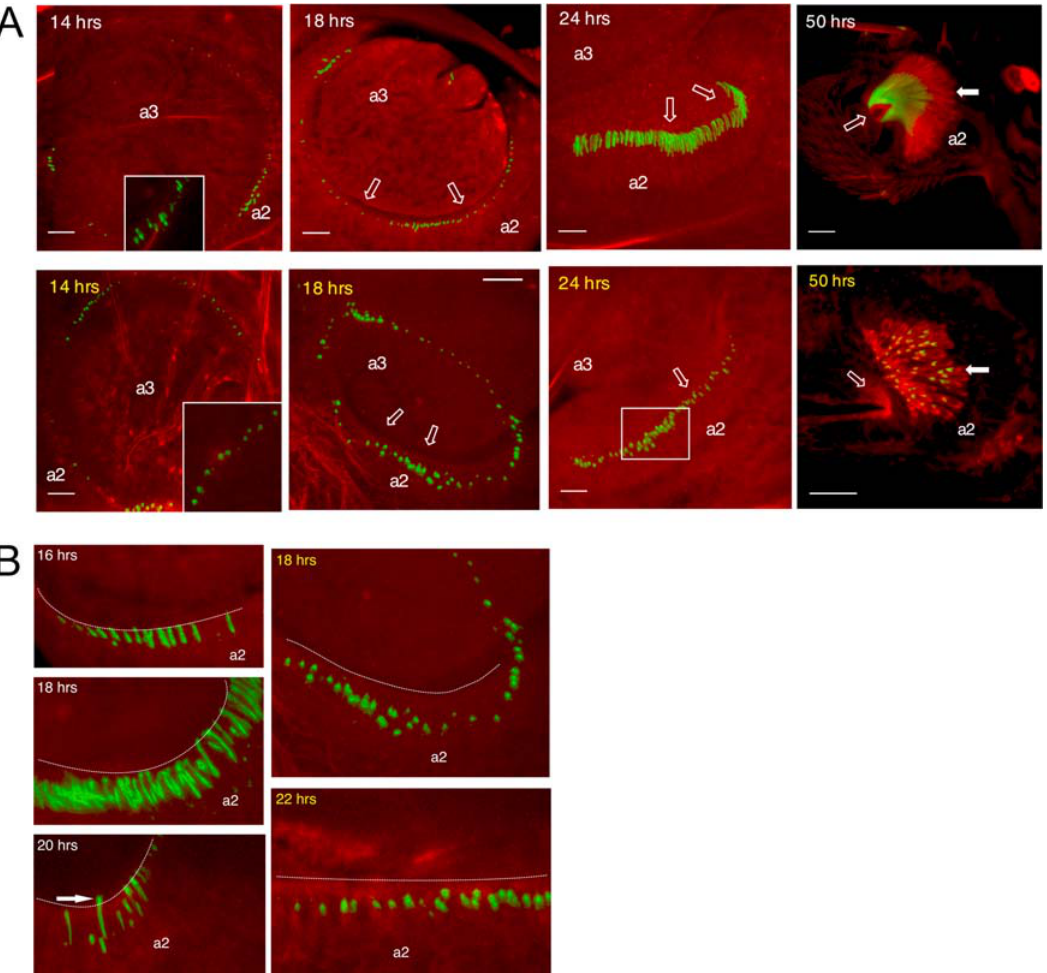
Figure 2. ck /MyoVIIA is necessary for JO organization during development. A: Comparison of control ( ck 13 /CyO ; white labels) vs. mutant ( ck 13 /ck 13 ; yellow labels) developing JO. Green channel: GFP-NompA labelling dendritic caps. Red channel: Texas red-phalloidin labelling actin filaments. Block arrows: developing scolopale rods. Open block arrows: direction of a2/a3 boundary. Box indicates disorganization of cap alignment in JO. Inset in 14 hrs control: in some cases the cap shows an elongated profile by this time. Inset in 14 hrs mutant antenna: magnification of the globular profile of the cap. Scale bar=20 m m. B: Similar staining and labelling as ‘‘A’’. Note dendritic caps juxtaposed with the perimeter of a2 (dotted line) or extending into the space between a2/a3 in controls (arrow; white labels). In mutants (yellow labels) the caps remain distanced from the future a2/a3 joint.